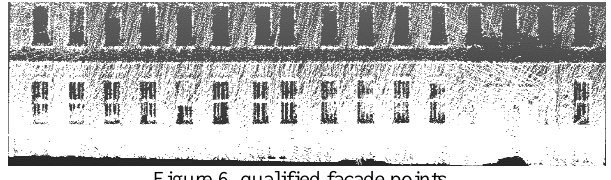
Figure 6. qualified façade points